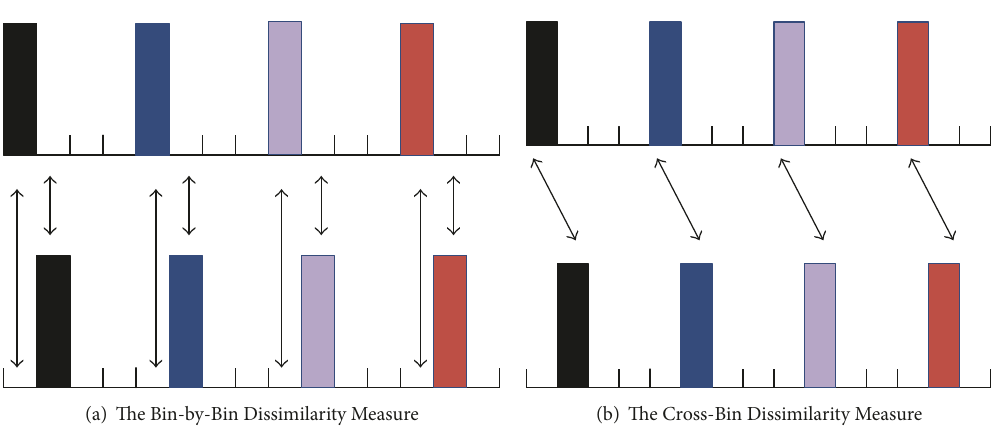
Figure 2: There are 4 different colors of rectangle for each histogram, and the value of each rectangle is 0.25. The dissimilarity in (a) is 2, while the dissimilarity in (b) is 1. When 𝑃 denotes the histogram above, and 𝑄 presents the histogram below. 𝑃 = [0.25, 0, 0,0, 0.25, 0, 0, 0, 0.25, 0, 0,0, 0.25, 0, 0] , 𝑄 = [0,0.25, 0,0, 0, 0.25, 0, 0, 0,0.25, 0,0, 0, 0.25, 0] .